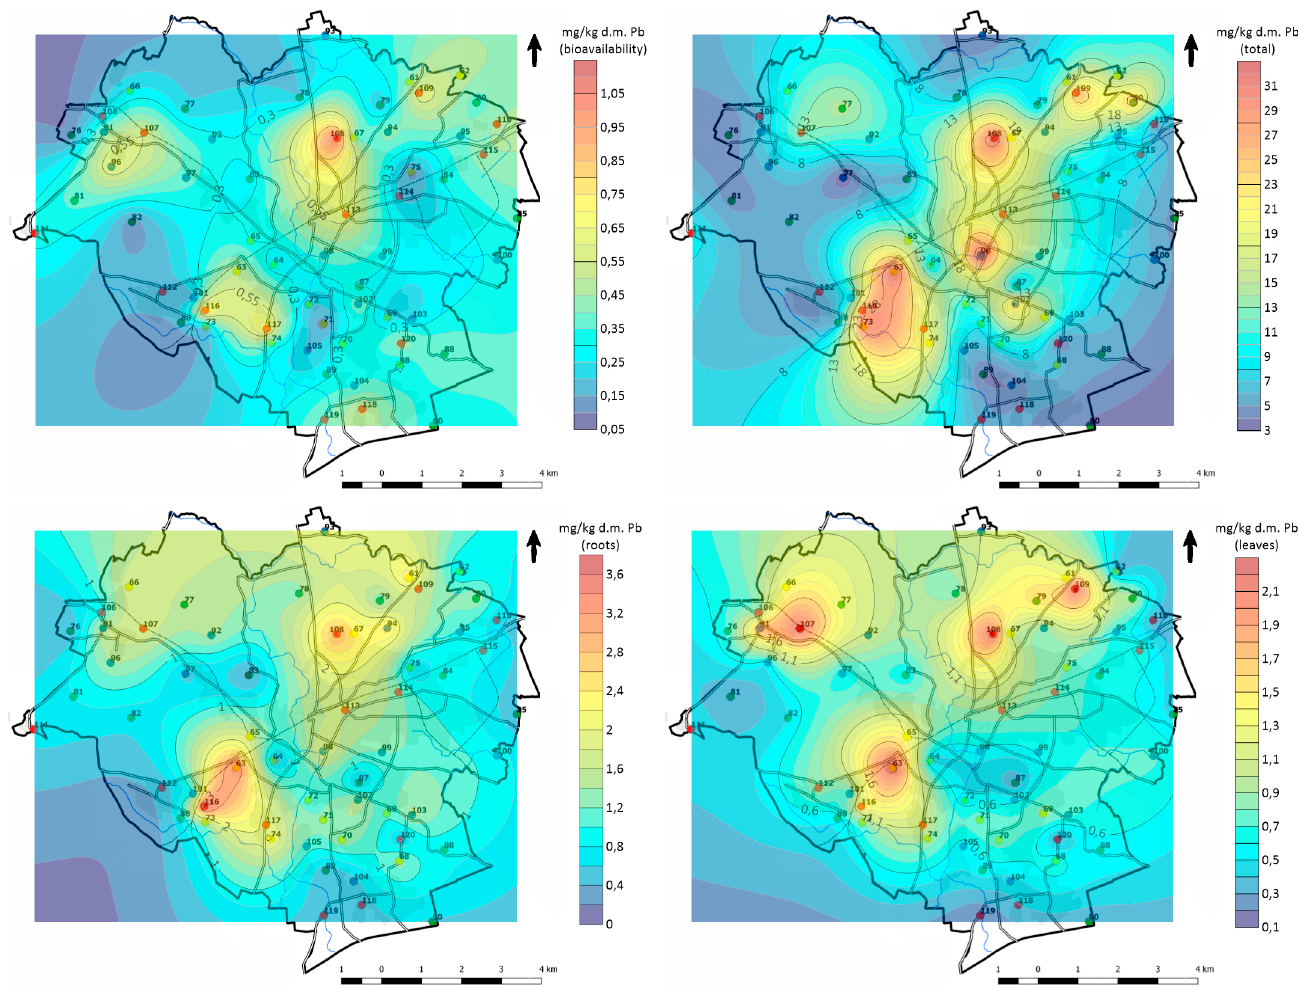
Figure 6. Lead content in the soils and common dandelions from Olsztyn (kriging method modelling). In Kielce, areas with significantly higher lead concentrations in relation to the back- ground values were identified. Such a situation was recorded for the sample (no. 48) The range of variability for lead concentrations in Olsztyn was smaller than in Kielce; collected at the filling station (type D). There, the extreme high values for the but, lead anomalies were found in this city, as well. The highest lead concentrations were observed in the samples collected from the areas belonging to the type A–urban allotment gardens (no. 63, 73), type C–urban green areas (no. 98), as well as type D–industrial areas (no. 108). As far as bioavailabilty is concerned, the maximum values were determined in such samples as no. 96 (type C) and 108, 109, 116, and 117 (type D). With regard to com- mon dandelion’s leaves, the maximum values were recorded in the samples no. 63 (type A), 107, 108, as well as 109 (type D); and when it comes to the roots–in the samples no. 63 (type A), 108, and 116 (type D). Like in Kielce, no significant relationships were found between the types of land use and high concentrations of lead in the soils and common dandelion. Similar spatial patterns are present on all maps of Kielce and Olsztyn, which indicates a strong spatial correlation between the total lead content and bioavailable frac- tion and the content of this metal in the common dandelion’s roots and leaves. In Kielce, the high lead load of the studied soils cannot be directly related to the ex- isting metal processing plants, such as iron and cast steel foundries. Certainly, the histor- ical exploitation and processing of metal ores in the city could have certainly had an im- pact on the increased lead content, especially in comparison with the studied soils of Ol- sztyn. However, there are more factors contributing to the increased accumulation of lead in the soils of Kielce. These include specific soil parent rocks shaping the geochemical background, defective buildings that do not take into account ventilation wedges, out- dated heating systems, etc. 4. Conclusions The analysis of the soils of Kielce and Olsztyn showed a slightly acidic, slightly alka- line pH, a dominant share of clayey sand and light clay, and high concentrations of or- ganic matter. The content of lead in the soils of Kielce was significantly higher than that in Olsztyn. This applies to both the total content and the bioavailable fraction of lead. It is influenced not only by the history of land use, which determines the anthropogenic factor, but also by the natural enrichment of the parent rock with lead. The share of bioavailable content of lead in relation to its total content was definitely much higher in the soils of Kielce. In the case of more contaminated ecosystem, a high spatial dispersion in the concentrations of bioavailable fraction was observed at the same time with a small range of lead concen- trations. This may indicate a higher lability of the soil environment in Kielce with regard to the content of analysed metal. The analysis of common dandelion in terms of lead concentrations showed that this metal is stabilised in the plant’s root – the roots accumulated lead at a higher level than